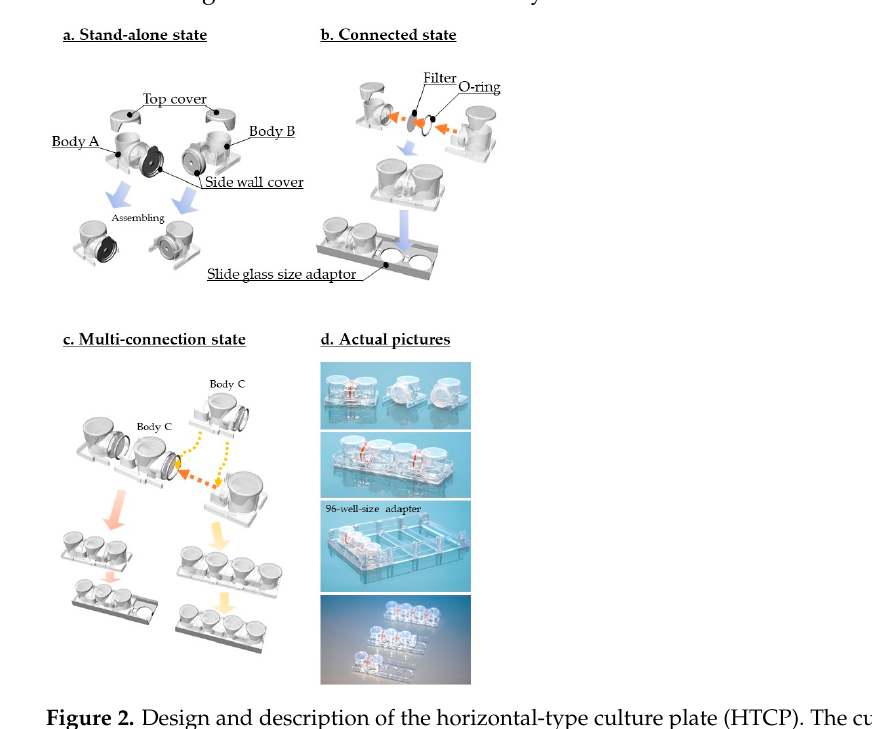
Figure 2. Design and description of the horizontal-type culture plate (HTCP). The culture vessel can be employed in two ways. ( a ) Initial monoculture mode. Bodies A and B are designed to allow the use of separated cell culturing. ( b ) Co-culture mode by connecting the two containers (combined state). In the connected mode, the two containers are joined from the beginning of cell culture. The height (volume) of the culture medium is used to control the amount of liquid that traverses the two containers, controlling the extent of co-culturing. ( c ) Body C is used for multiple connections, with a coupling mechanism on both the left and the right sides of the container. How to use are depicted in Figure S4. ( d ) Actual pictures. This product (HTCP) is already commercially available through AR Brown Co., Ltd. (Tokyo, Japan), Fujifilm Wako Pure Chemicals Corporation (Tokyo, Japan), Blast Inc. (Ka- wasaki, Japan), AdvantigenBioScience L.L.C. (Madison, USA), Bulldog Bio. Inc. (Ports- mouth, USA), Xceltis GmbH (Mannheim, Germany), and 1st PhileKorea Inc. (Seoul, Ko- rea). The product is named “ ICCP,” “ NICO-1,””UniWells,” and “Pair-N-Share Tandem Co-Culture Wells & Plates ” , but the product itself is the same.